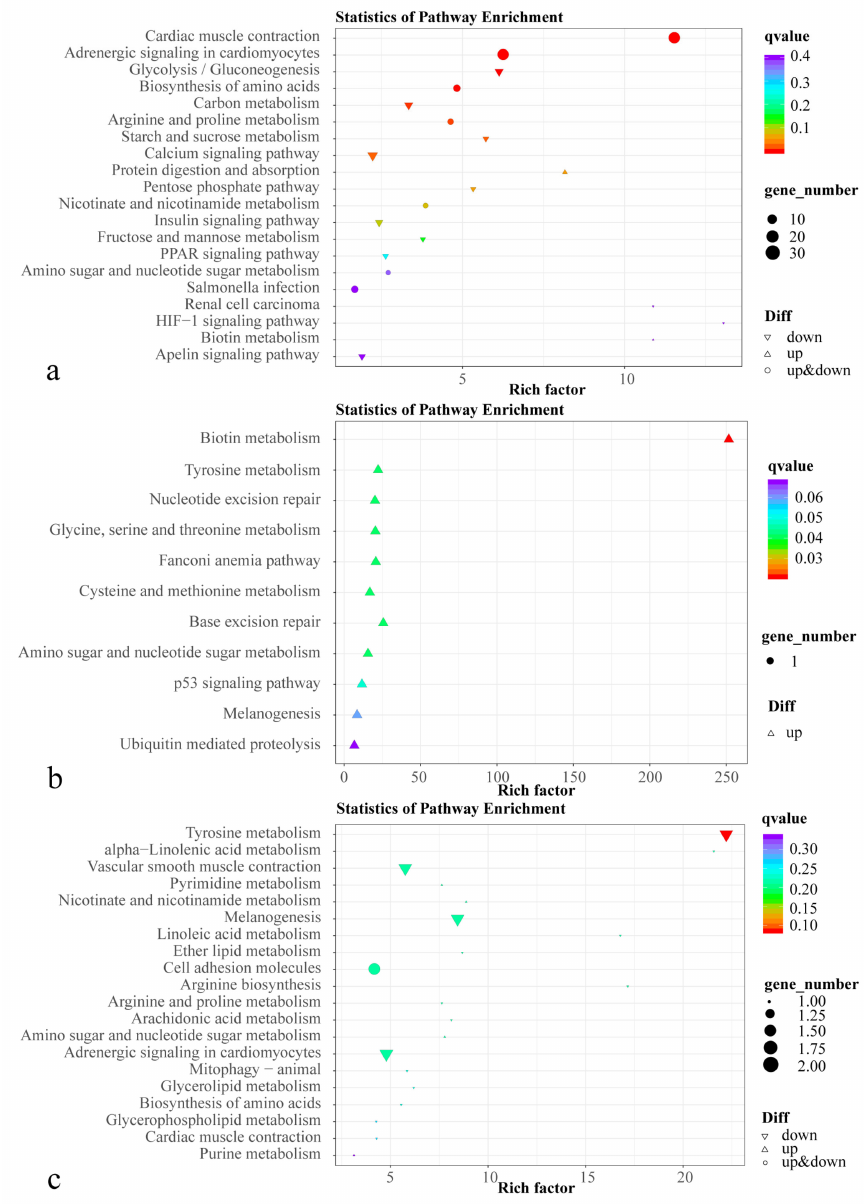
Figure 3. KEGG enrichment of differentially expressed genes in comparisons between C, AS, and HP groups. ( a ) HP vs. C; ( b ) AS vs. C; ( c ) HP vs. AS. The letter C is control, AS is synthetic astaxanthin, HP is natural